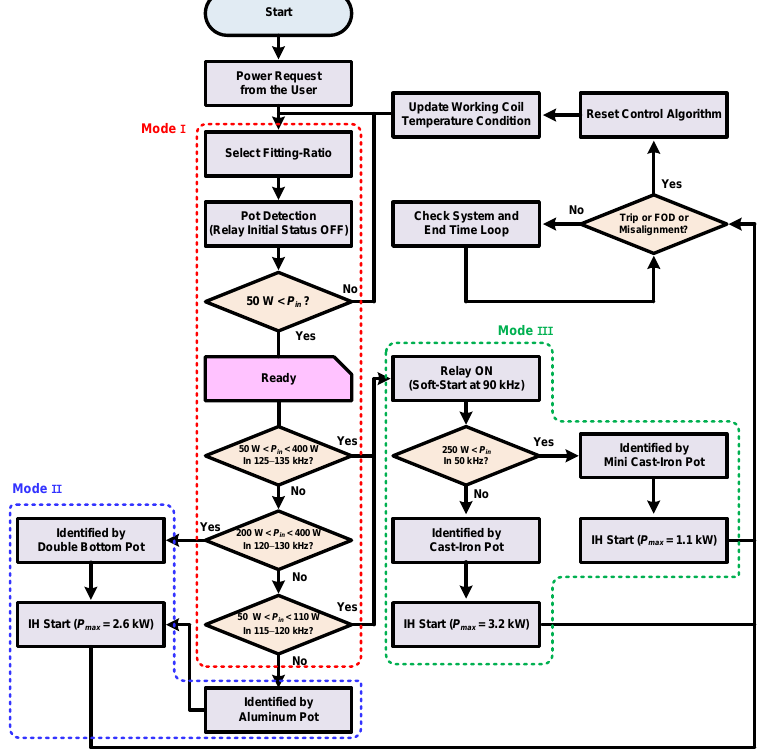
Figure 14. Control algorithm flow chart for the proposed all-metal domestic IH system.